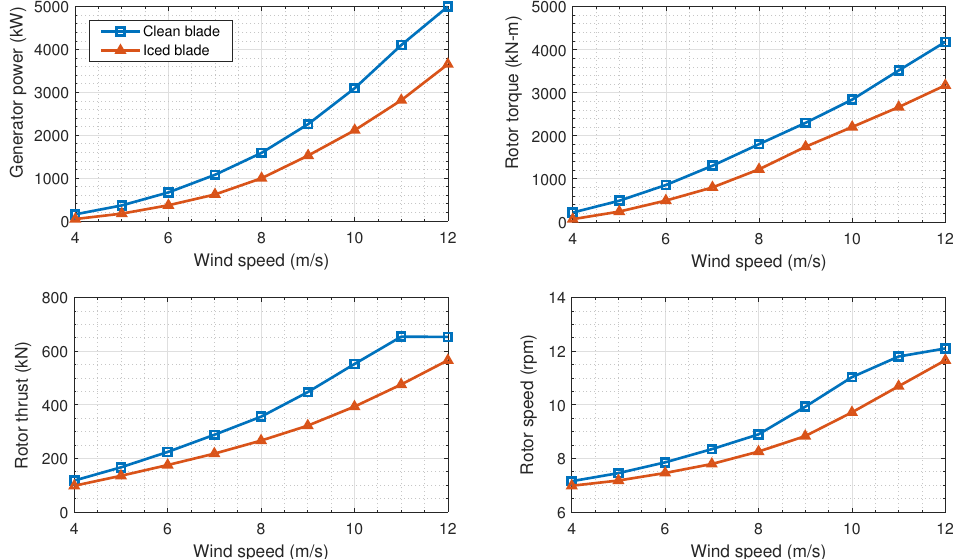
Figure 12. Comparison of the steady-state characteristics of turbine simulated with clean and iced